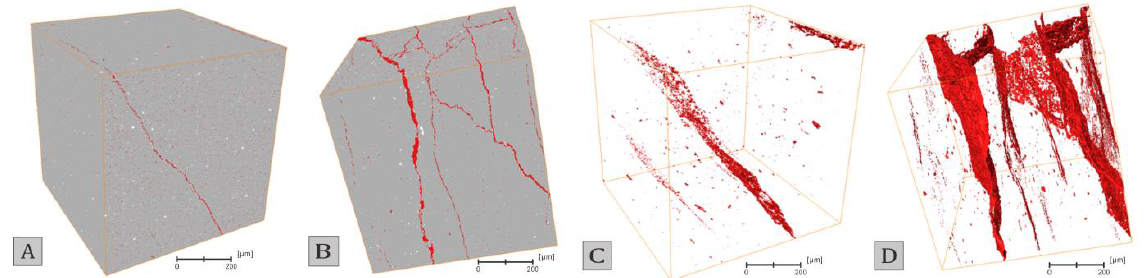
Figure 3. Three-dimensional distribution of bedding-related micro-fractures. ( A ) YB102-7 3923.19 m 3D gray scale model of the core; ( B ) FY1-13 2636 m 3D gray scale model of the core; ( C ) YB102-7 3923.19 m 3D pore model of the core; ( D ) FY1-13 2636 m 3D pore model of the core.